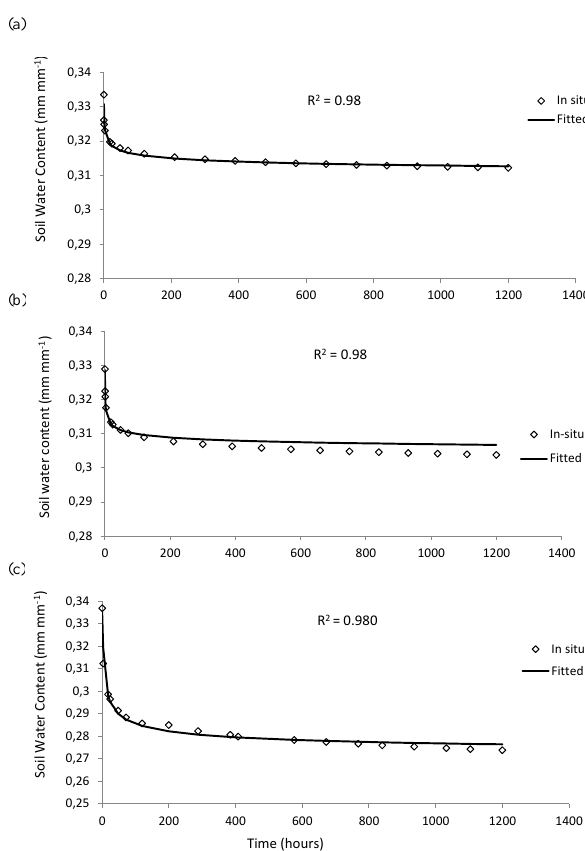
Fig. 10. Fitting of the effective drainage curves by the van Figure 10 Fitting of the effective drainage curves by the van Genuchten-Mualem (1980) Genuchten–Mualem (1980) model during optimisation of effective model during optimisation effective hydraulic parameters for the Tukulu (a), Sepane (b), and hydraulic parameters for the Tukulu, Sepane, and Swartland soils. Swartland (c) soils.